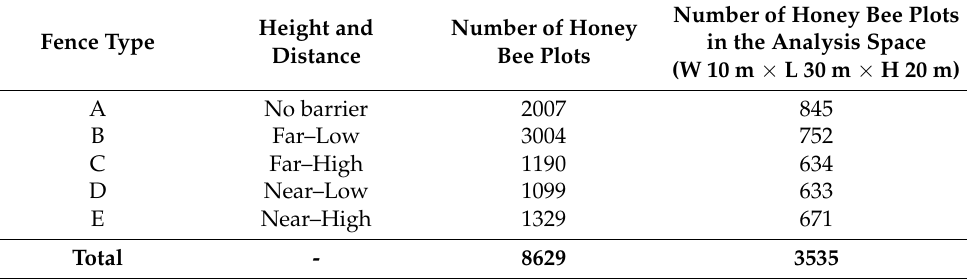
Table 3. Number of honey bee plots observed by the 3D scanner.